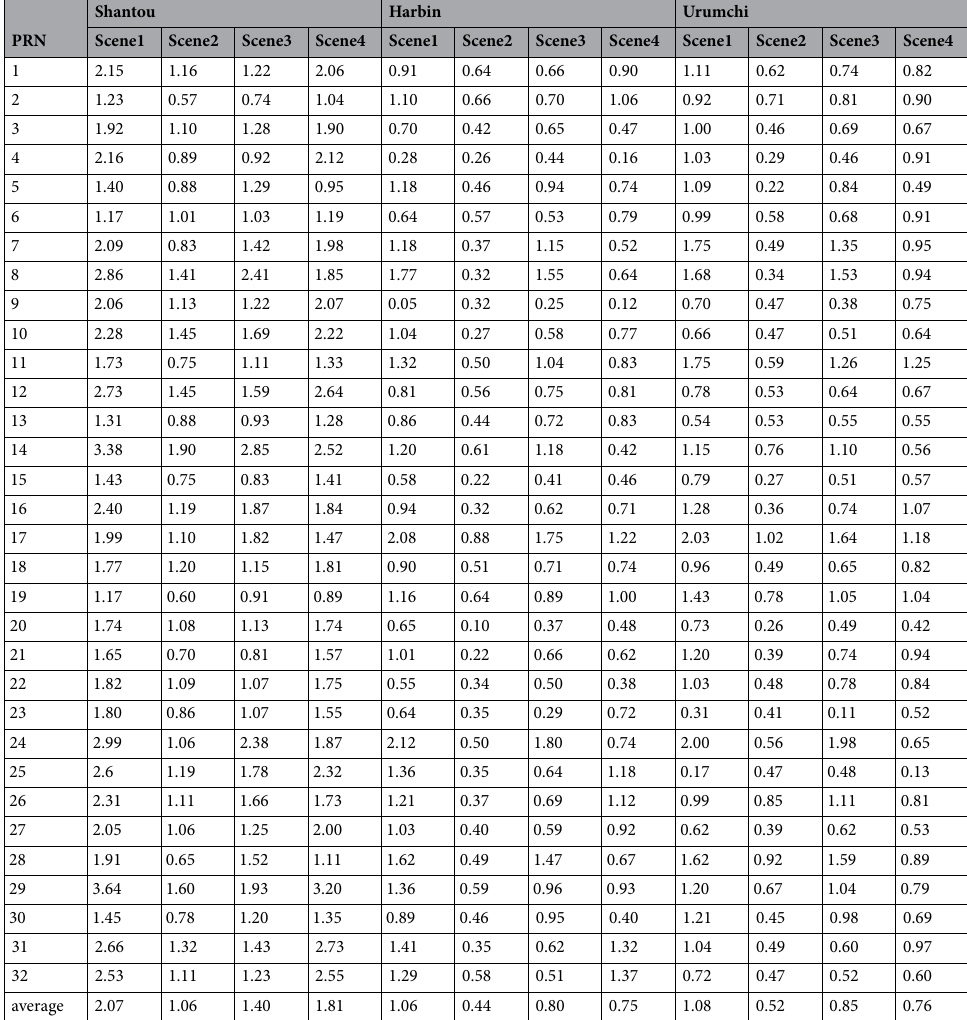
Table 5. Evaluation of the UERE under different scenes (Shantou, Harbin and Urumchi, unit: m).